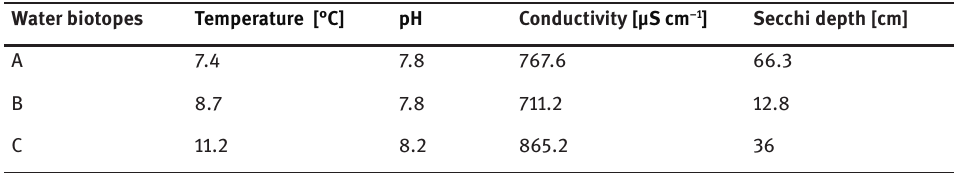
Table 1: Physico-chemical water parameters in two reservoirs (A-B) and drainage ditch (C) in 2015. Water